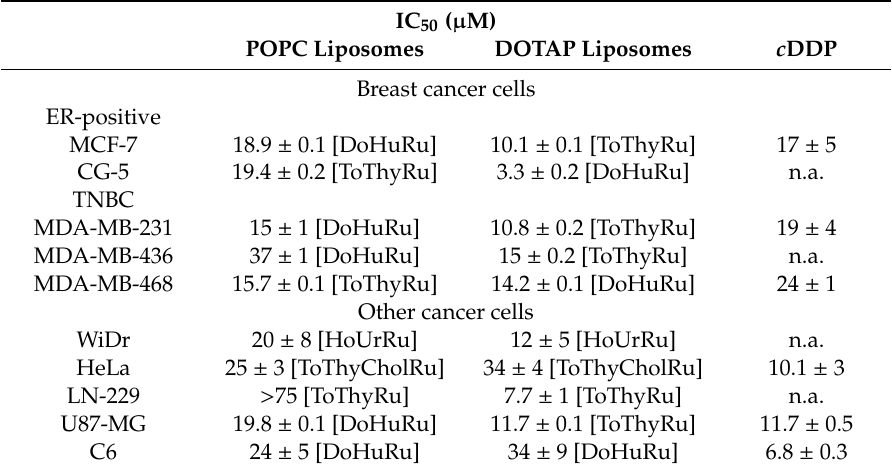
Table 1. Best IC 50 values ( µ M) relative to the AziRu complex lodged in POPC and DOTAP liposomes (the specific nucleolipid Ru complex is indicated in brackets) measured in preclinical models, including cancers other than BC [57,87]. IC 50 values for cisplatin ( c DDP), as cytotoxic reference drug, are included for comparison. Noteworthy, in the same models in vitro , IC 50 values for the naked AziRu complex are constantly higher than 250 µ M. (n.a. = not